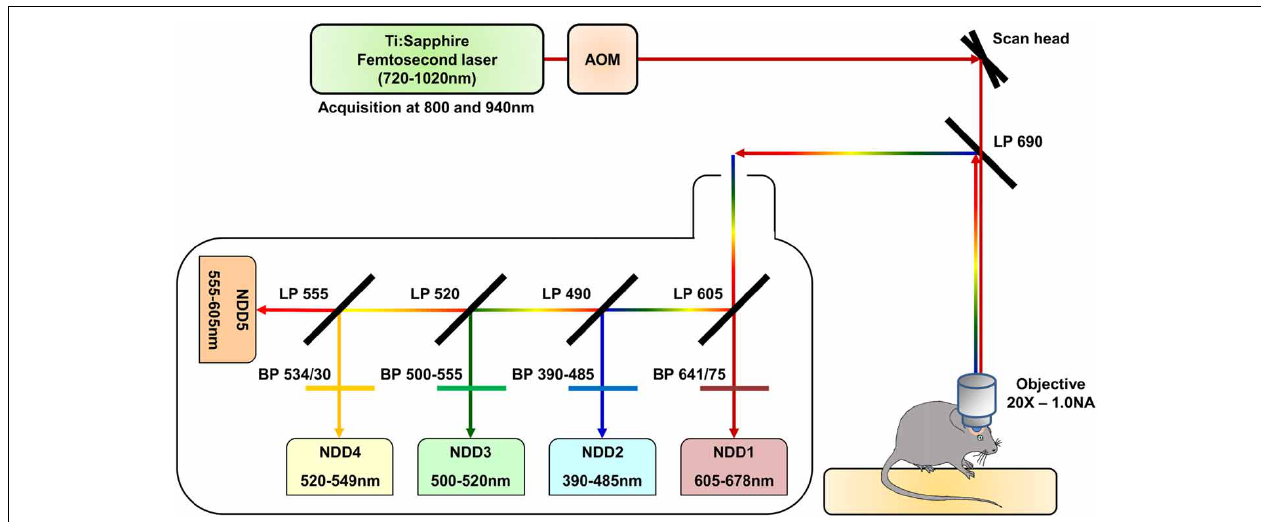
FIGURE 1 | Schematic representation of the two-photon microscopy setup. The excitation beam is produced by a femtosecond pulsed infrared tunable (720–1020nm) laser (Mai-Tai, Spectra Physics). The laser power is modulated by an Acousto-Optic Modulator (AOM). The beam is scanned in the xy direction by galvanometric mirrors present in the scan head of a Zeiss LMS 7 MP two-photon microscope. The beam then passes through a LP690 dichroic mirror and is focused in